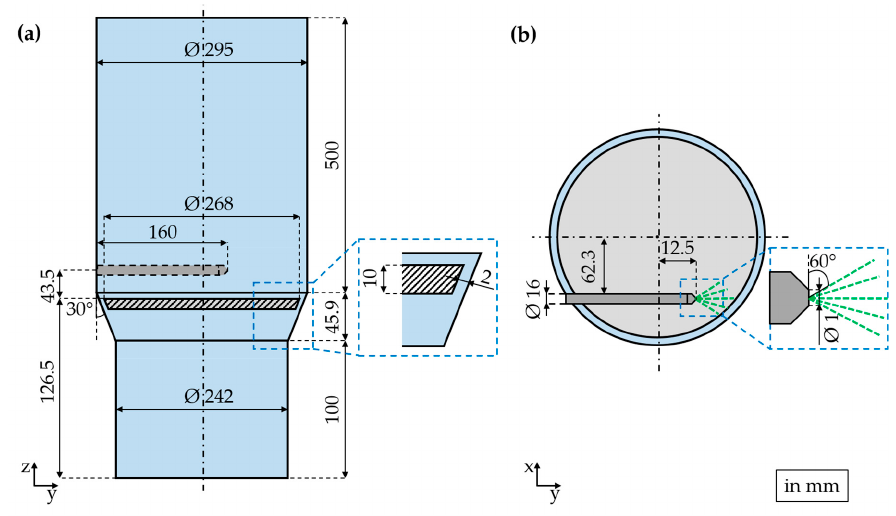
Figure 3. Geometry of the simulated rotor granulator: Side view ( a ) and top view ( b ).